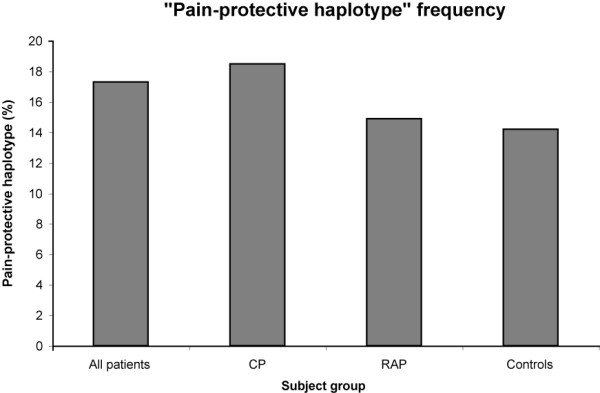
Pain-protective haplotype frequency among subject groups. The frequency of the "pain protective haplotype", given as a percent of the total haplotype count. "All patients" includes both CP and RAP. There was no significant difference between groups. "Pain protective haplotype" count: All pts = 137, CP = 98, RAP = 39, Controls = 67.